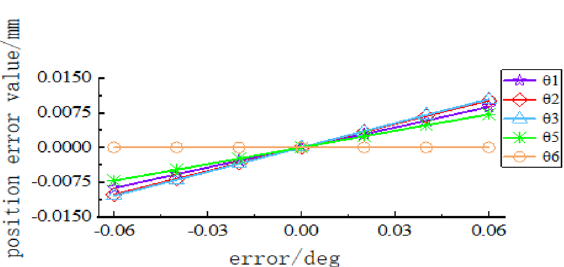
Figure 8. Sensitivity curve of rotation angle error to terminal position